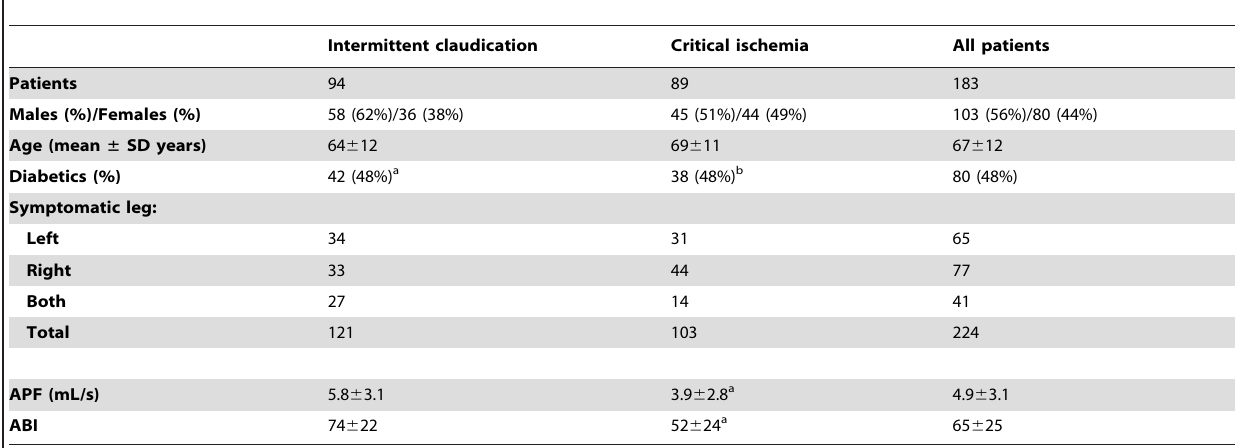
Table 1. Patient